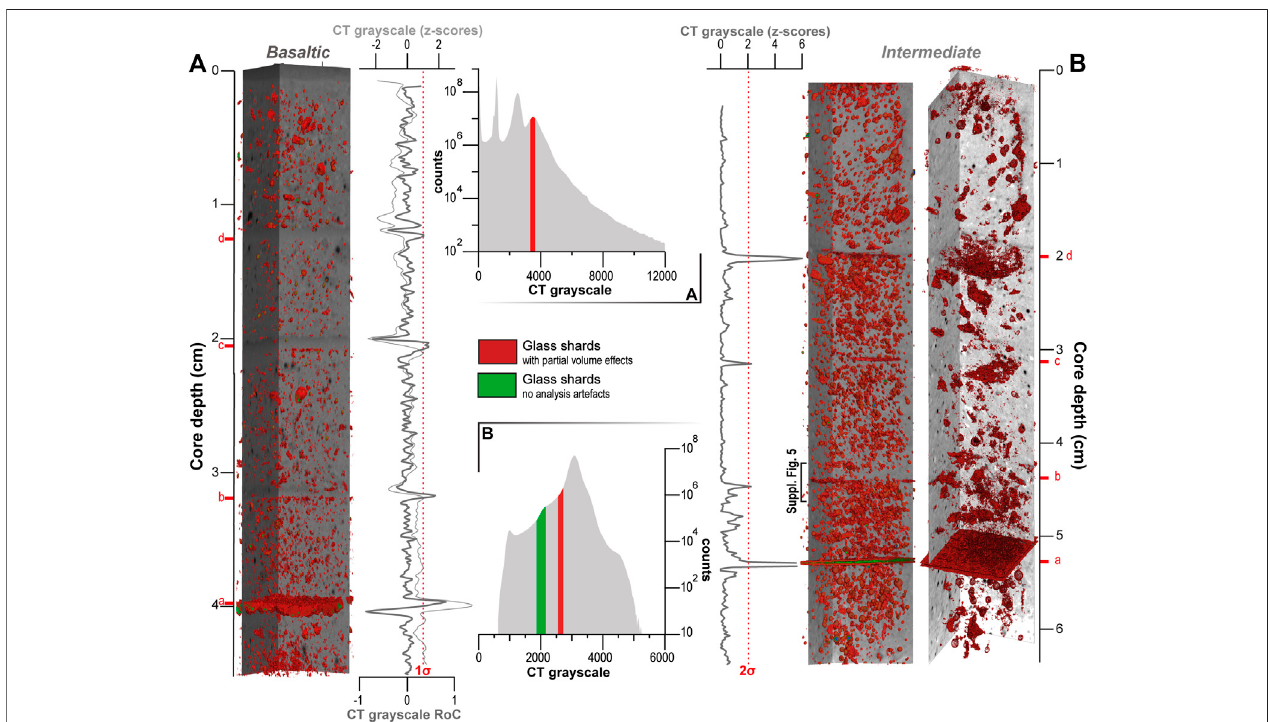
FIGURE 5 | Inter-connected 2-D CT orthoslices and 3-D representations of horizons of basaltic (A) and intermediate (B) glass in the synthetic minerogenic cores scanned for this study. For the scanned intermediate phantom, we show visualizations based on unprocessed data (left) and following the extraction of porosity (right; also see Minerogenic section). The histograms show the grayscale value distribution of each scan in gray, while highlighting the range of partial-volume affected glass in red and pure glass in green. Down-core CT grayscale variability is plotted as standardized z-score values, and Rates of Change [RoC; panel (A) also see Minerogenicsection].Aredstippledlineshowstheonetotwo σ rangeofRoC[panel (A) ]andz-scores[panel (B) ].Thepositionofeachaddedglasshorizonishighlighted with a red dash (and letter; Figure 1